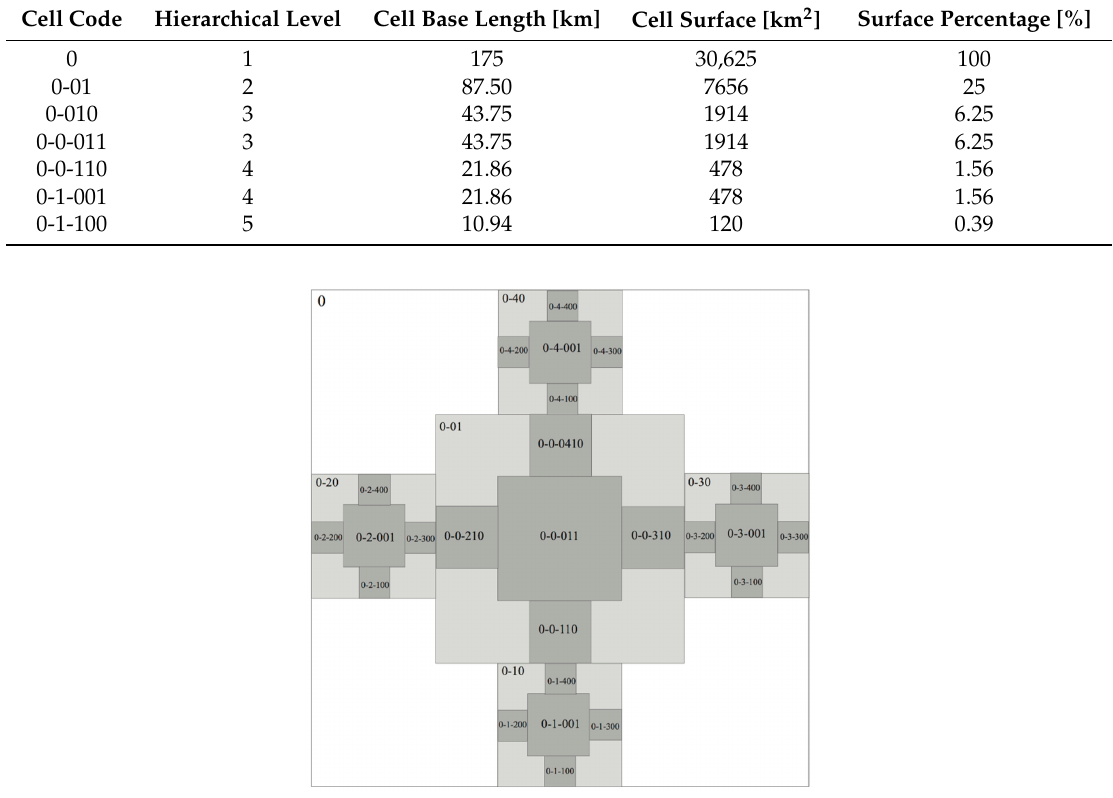
Figure 2. Coding system of the spatial model at iteration steps 0–3.